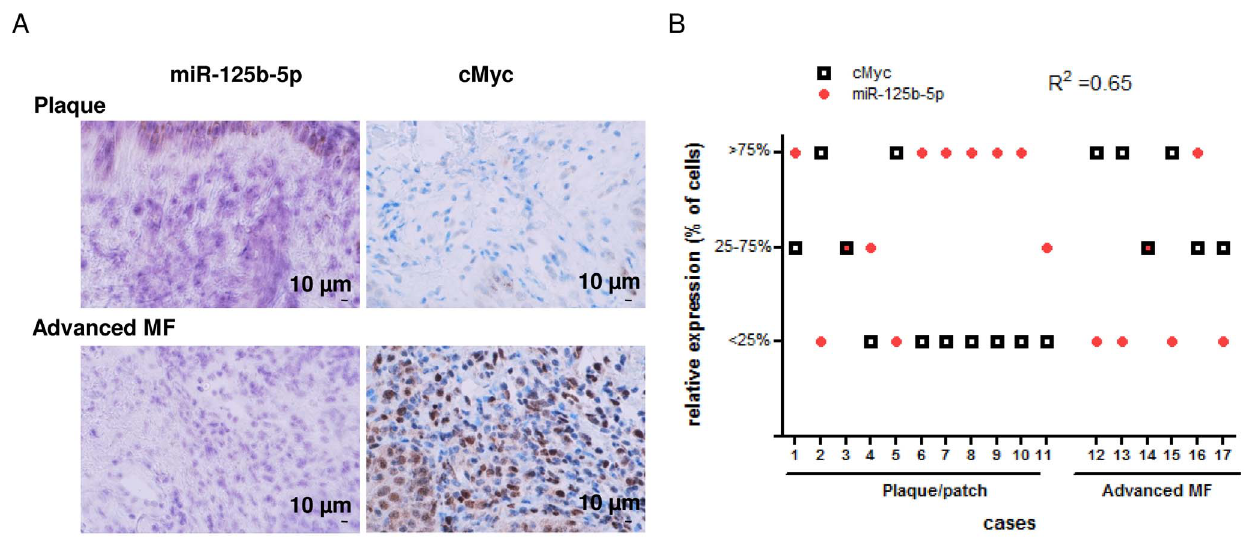
Figure 5. miR-125b-5p inversely correlates with cMyc expression in mycosis fungoides. (A) Representative cases from the 17 mycosis fungoides specimens (plaque (T2), n=11; advanced mycosis fungoides (T3), n=6) analyzed by IHC for cMyc and by ISH for detection of miR-125b-5p. Scale bar, 10 m m. (B) The 17 mycosis fungoides specimens were classified into three categories depending on the percentages of miR-125b-5p or cMyc positive tumour cells. The Pearson coefficient (R 2 =0.65; P , 0.05) indicates an inverse correlation between miR-125b-5p and cMyc